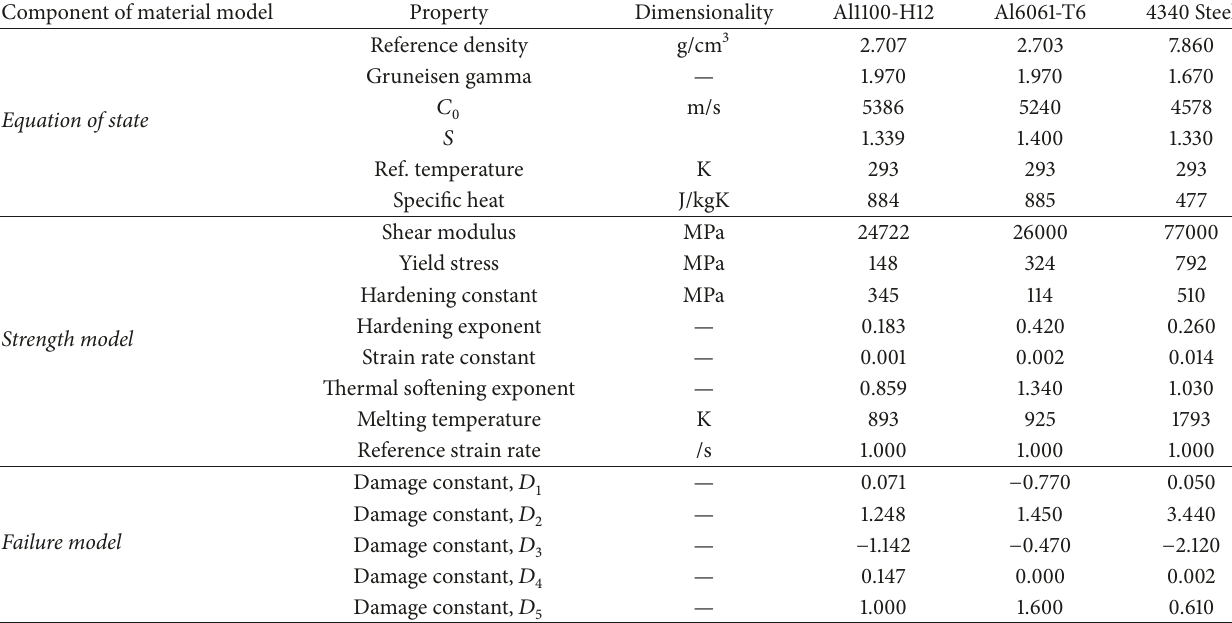
Table 2: Properties of